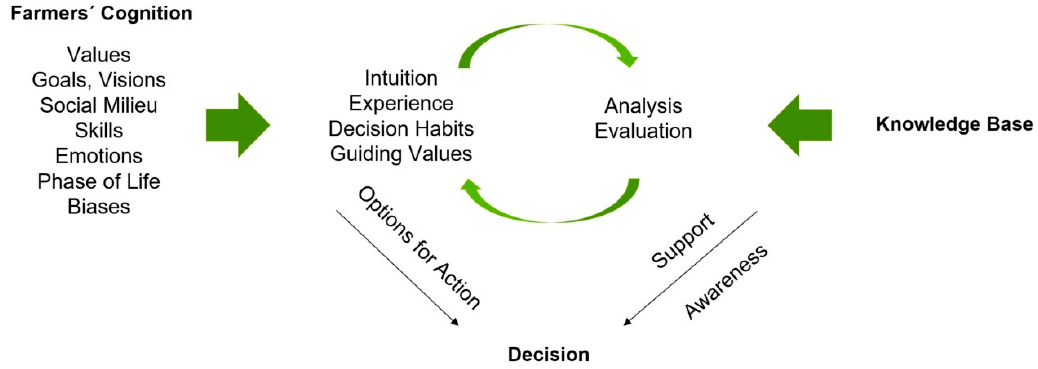
Figure 9. Influences in decision making (modified from [6]).